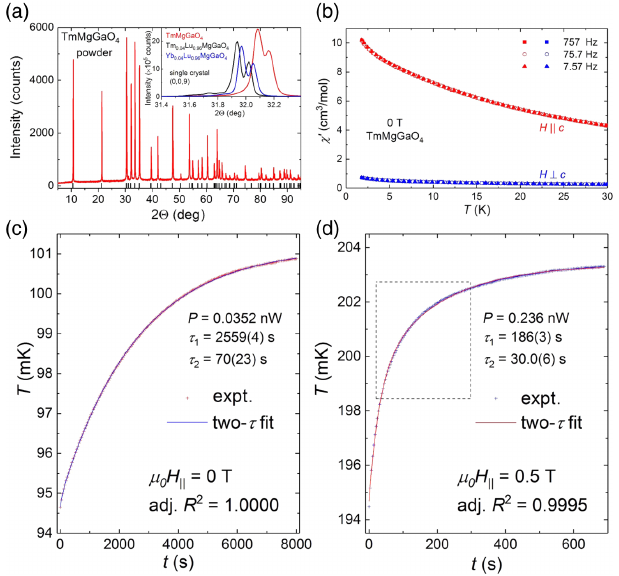
FIG. 7. (a) Powder x-ray diffraction measured on the poly- crystalline sample of TmMgGaO 4 at 300 K. The black bars show the reflections calculated with the crystal structure data reported by Cevallos et al. [32]. The inset shows the strongest Bragg peaks (0,0,9) measured on the single crystals of TmMgGaO 4 , Tm 0 Lu 0 MgGaO 4 , and Yb 0 Lu 0 MgGaO 4 , respectively. . 04 . 96 . 04 . 96 (b) Temperature dependence of the ac susceptibility (the real part) measured on the single crystal of TmMgGaO4 down to 1.8 K. Thermal relaxation data of TmMgGaO 4 single crystal measured (c) at 0 T at ∼ 0 . 1 K, (d) at 0.5 T at ∼ 0 . 2 K, with the lines representing the least-squares fits using the two- τ model [39]. For the definition of adj. R 2 , see Ref.